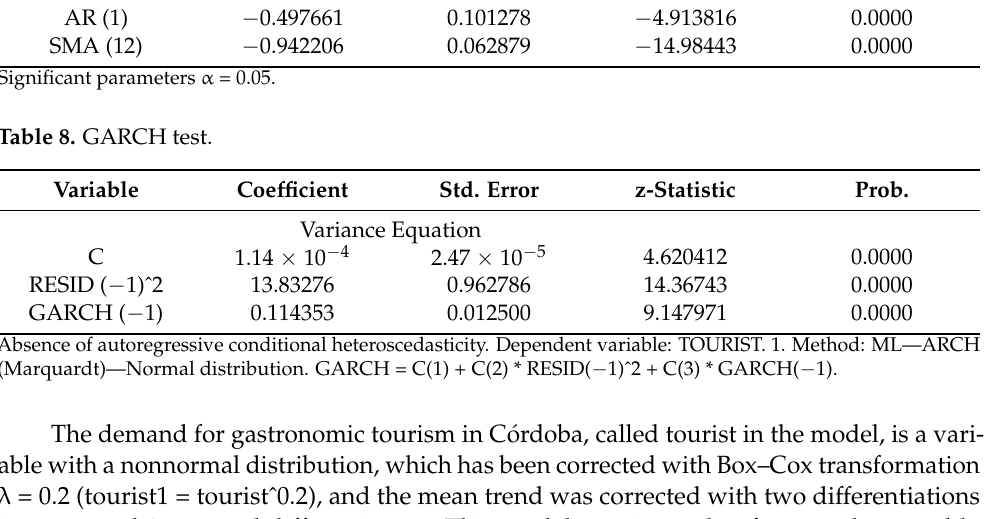
Table 7. Estimation of the SARIMA model.